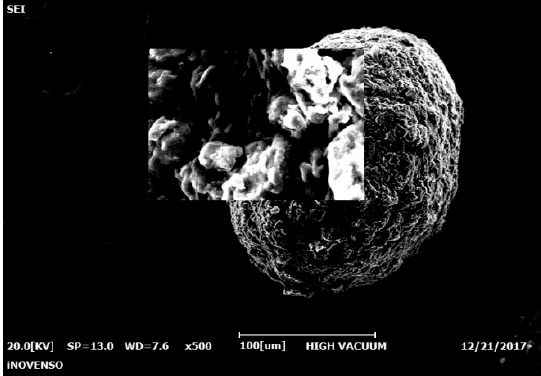
Figure 4. SEM image of an empty chitosan microparticle .